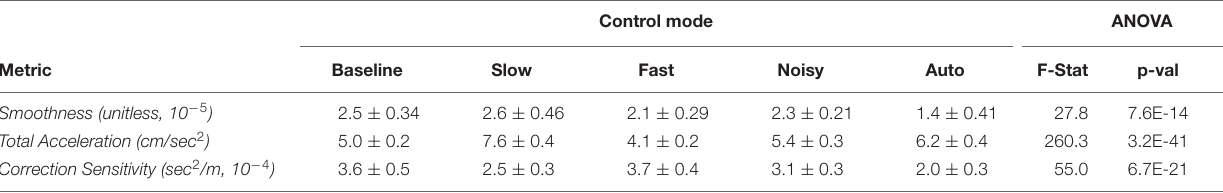
TABLE 3A | Mean value comparisons for performance efficiency metrics across control modes.